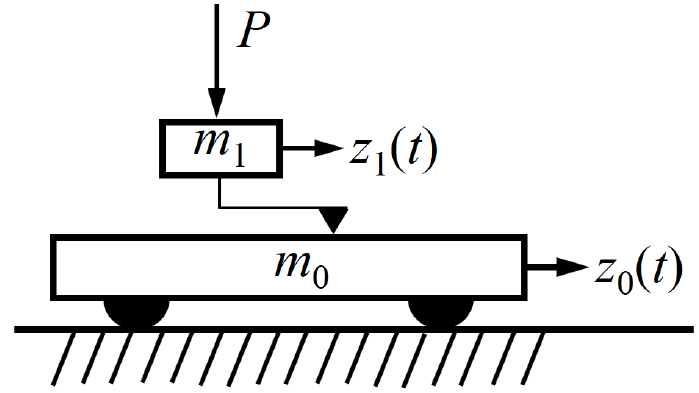
Figure 3. Schema of plate ‐ slider